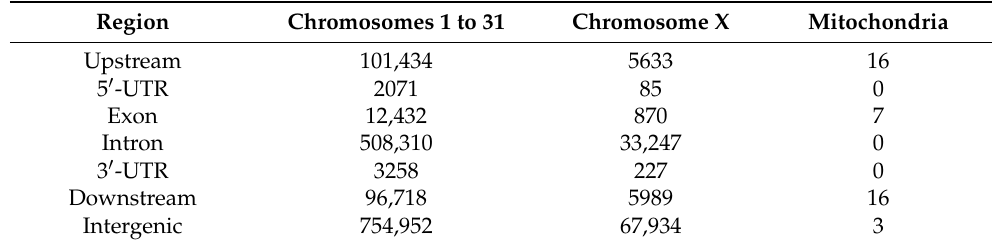
Table 2. Characterisation of insertions and deletions detected in 101 Thoroughbred racehorses. Region